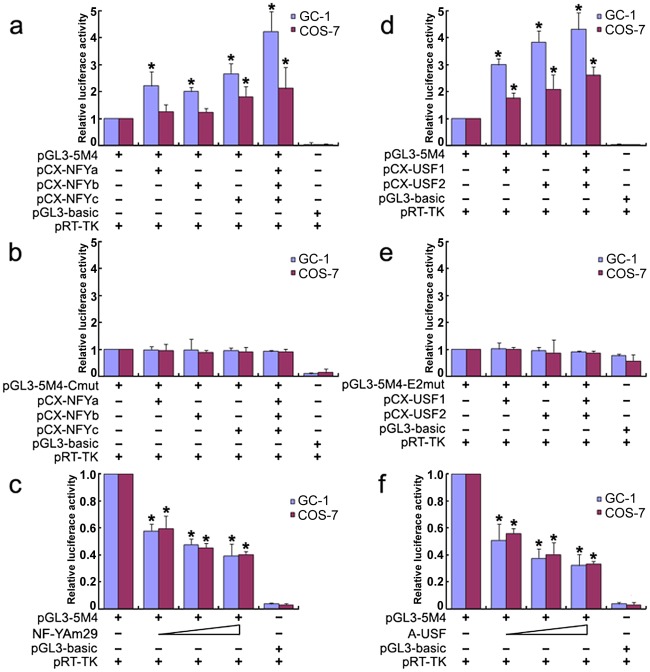
Over-expression of NF-Y or USF increases Miwi-luciferase activity.a), Over-expression of NF-Y upregulates Miwi-luciferase activity. GC-1 or COS7 cells were transfected with 0.2 µg pGL3-5M4 and 0.2 µg NF-Y expression plasmids (pCX-NFYa, pCX-NFYb, pCX-NFYc) as indicated. b), The mutated CCAAT box construct pGL3-5M4-Cmut (0.2 µg) contransfected with NF-Y expression plasmids (pCX-NFYa, pCX-NFYb, pCX-NFYc) as indicated, does not increase the Miwi-luciferase activity. c), The dominant negative NF-Ya expression plasmid NF-YAM29 (0.1 µg, 0.2 µg, 0.3 µg) was cotransfected with 0.2 µg pGL3-5M4, which inhibits Miwi-luciferase activity. d), Over-expression of USF1/2 upregulates Miwi-luciferase activity. pGL3-5M4 (0.2 µg) was cotransfected with 0.2 µg expression plasmids (pCX-USF1 and/or pCX-USF2) into GC-1 or COS7 cells. e), E2 box mutant pGL3-5M4-E2mut (0.2 µg) was cotransfected with 0.2 µg USF1 and/or USF2 expression plasmids (pCX-USF1 and/or pCX-USF2), indicating no increase in luciferase activity. f), The dominant negative USF expression plasmid A-USF (0.1 µg, 0.2 µg, 0.3 µg) was cotransfected with 0.2 µg pGL3-5M4, which inhibits Miwi-luciferase activity. pGL3-basic was employed as a negative control. pRT-TK served as an inner control for transfection efficiency. The relative luciferase activities to the 5M4 construct were determined by luciferase assay. Cells were harvested 24 hours post-transfection, and luciferase activity was measured and normalized to Renilla luciferase activity. All transfection experiments were repeated at least three times and the data are shown as the fold increase or decrease over the luciferase activity of pGL3-5M4. Mean ± S.D. are shown. *, P<0.05, as compared to the 5M4 wild-type construct.